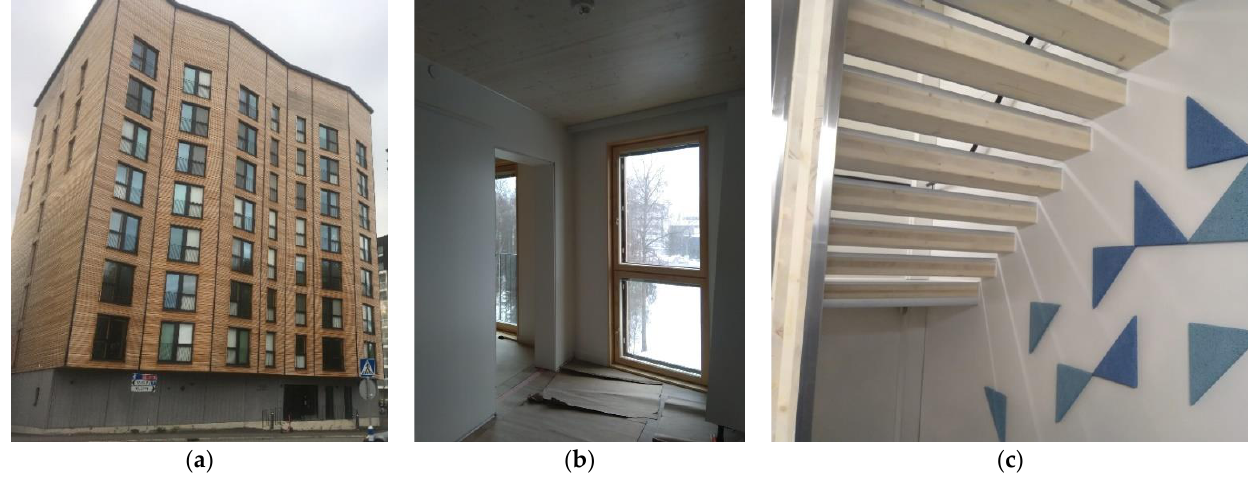
Figure 9. As Oy Tampereen Niemenrannan Rantapuisto — Raamikatu 32, Niemenranta: ( a ) exterior view; ( b , c ) interior views (photos courtesy of Suomen metsäkeskus).